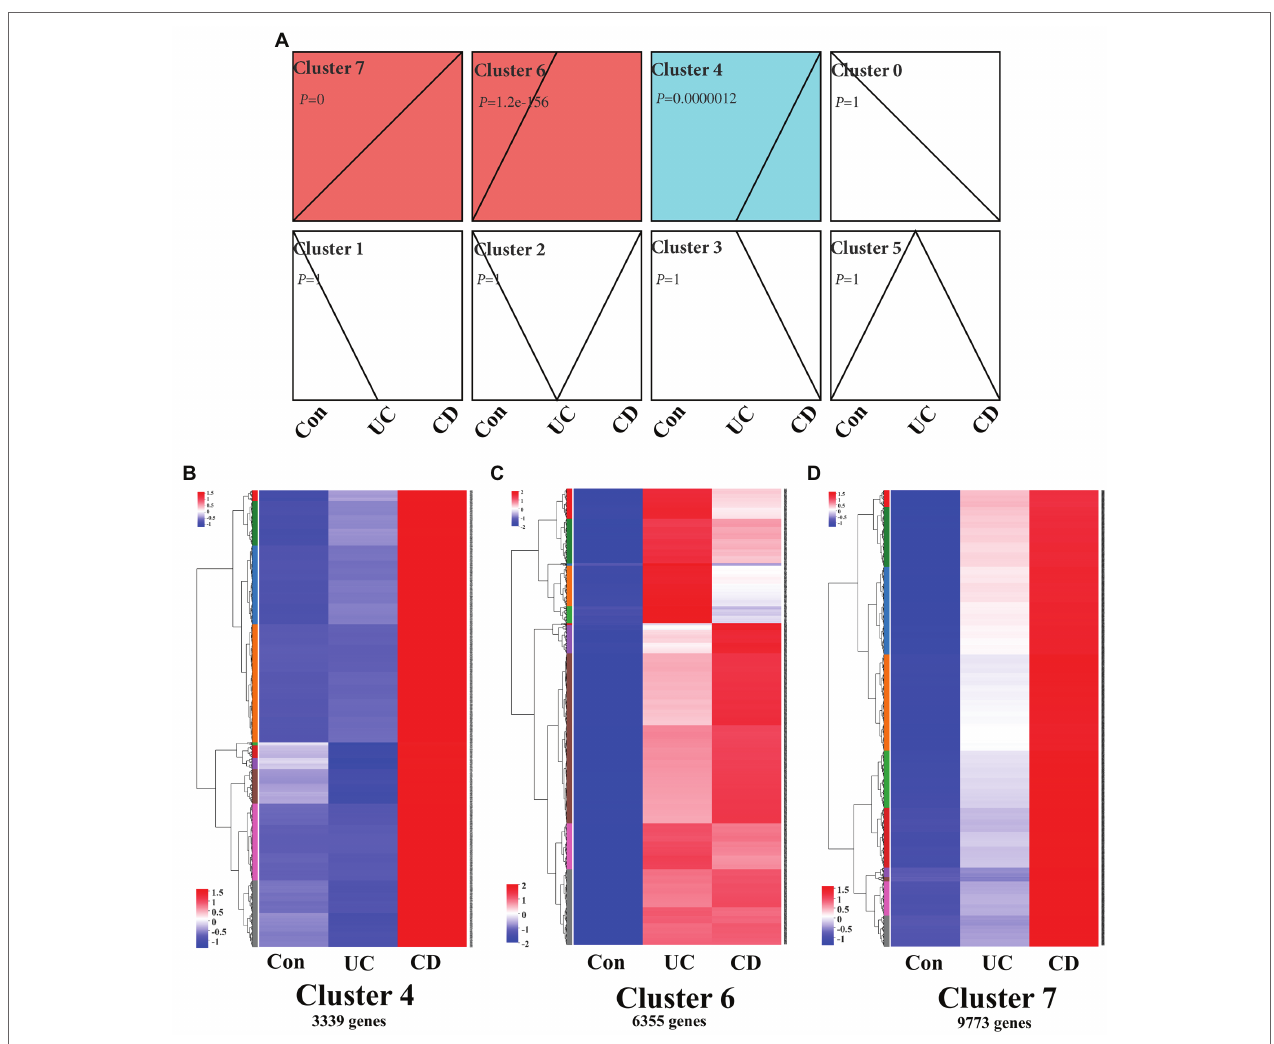
FIGURE 2 | Clustering profile of intestinal mucosa signaling in IBD patients. (A) Trend analysis chart showing gene expression profile in intestinal mucosa in IBD patients using a time course analysis. Chart shows all active genes were divided into eight clusters, three of which [i.e., cluster 4 ( p = 0.0000012), cluster 6 ( p = 1.2e–156), and cluster 7 ( p = 0)] were significant. Time course clustering algorithm: STEM, p < 0.05. Gene expression heatmaps of cluster 4 (B) , cluster 6 (C) , and cluster 7 (D) , which contained 3,339, 6,355, and 9,773 genes, respectively. Con: control population, n = 6; UC: ulcerative colitis patients, n = 12; and CD: Crohn’s disease patients, n =